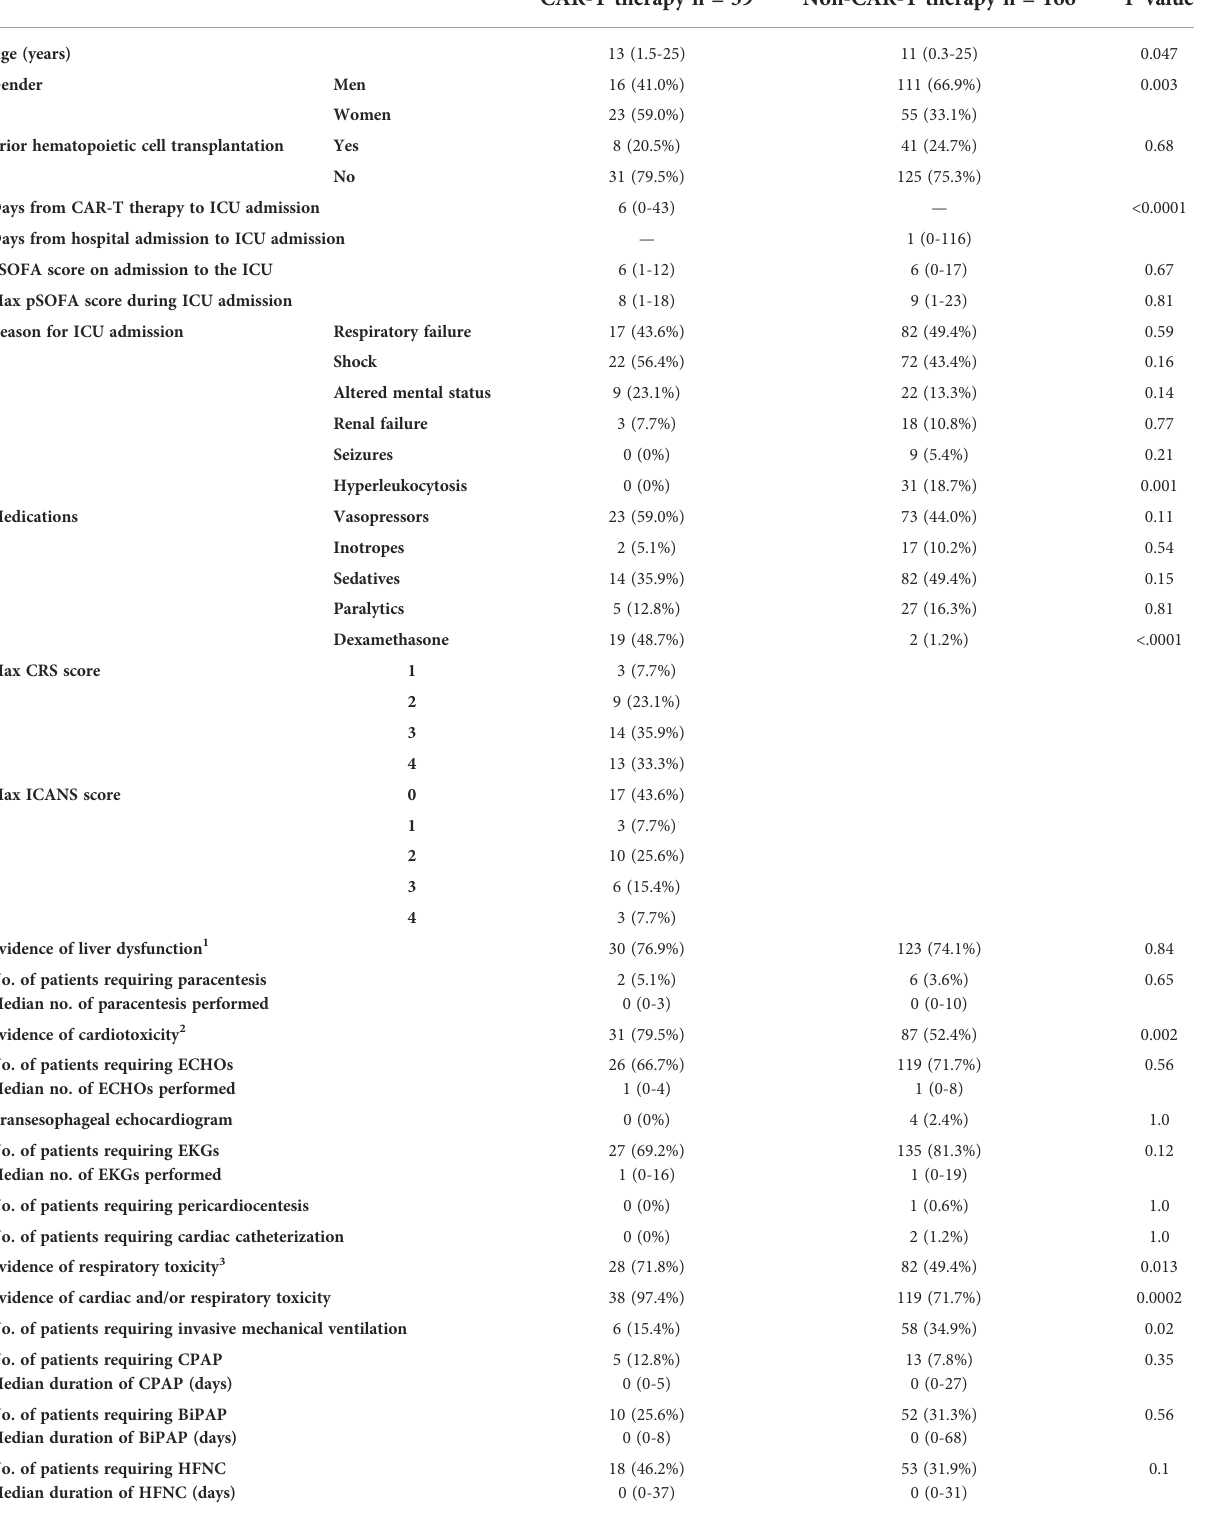
TABLE 1 Characteristics, resource utilization, and clinical outcomes of patients with acute lymphoblastic leukemia admitted to the intensive care